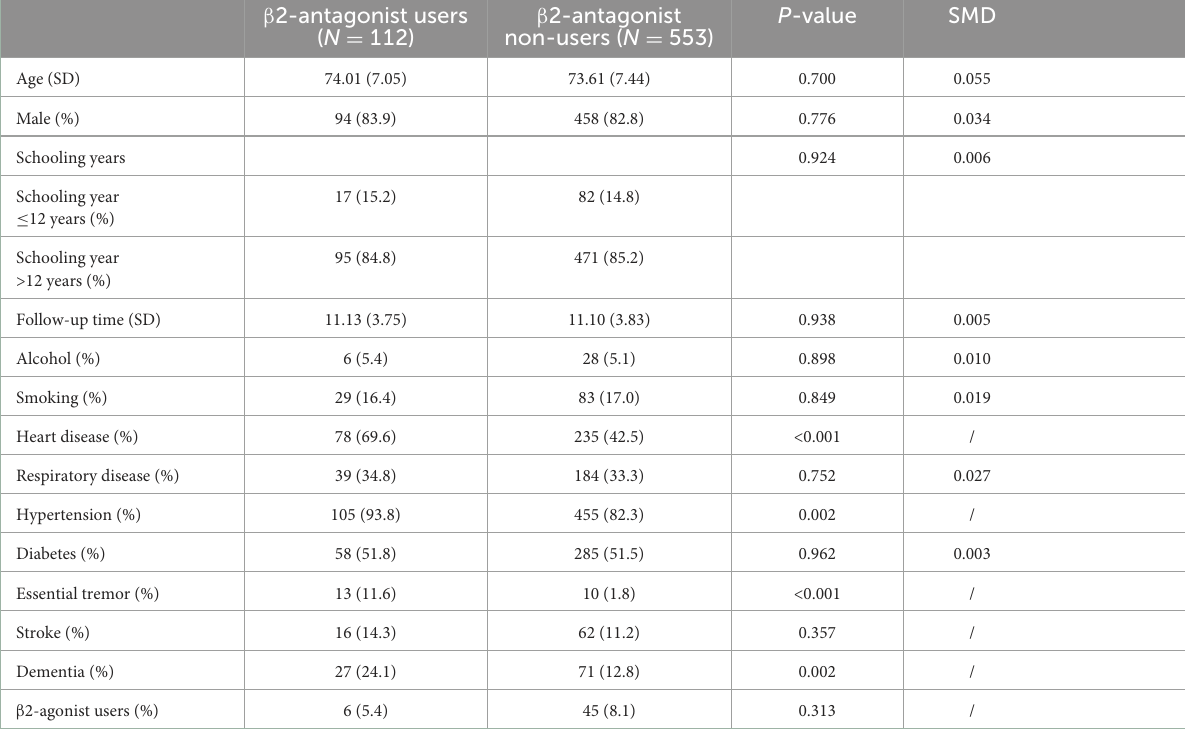
TABLE 3 Characteristics of β -antagonist users and their matched controls. β 2-antagonist users ( N = 112)